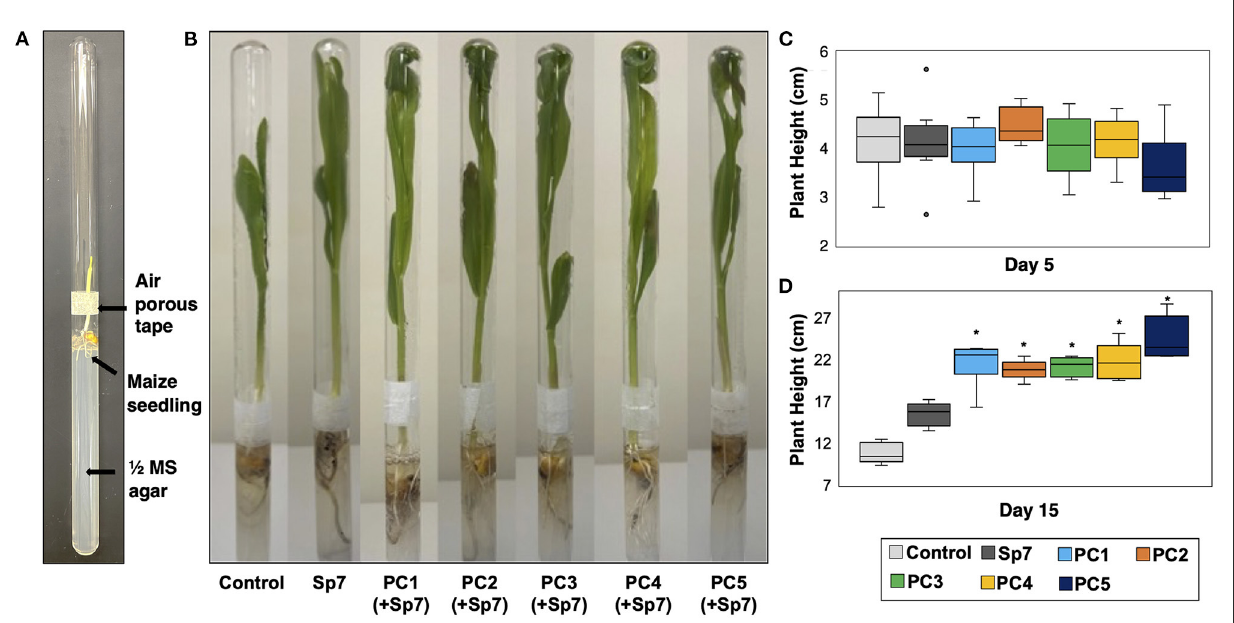
FIGURE5 Growth of axenic maize seedlings in a growth chamber environment. (A) A double-tube growth chamber was used for accomodating surface-sterilized and germinated maize seedlings after inoculation with an ultrapure water blank (control), Sp7, or Sp7 with a promoter consortium (PC1-PC5). Two test tubes were attached in a mouth-to-mouth fashion with air-porous tape. (B) Growth of the maize seedlings in the double-tube growth chamber at day 15. (C) Comparison of plant heights for each treatment at day 5 and (D) at day 15 ( * Wilcoxon Rank test: p -value < 0.01). n = 6 replicate